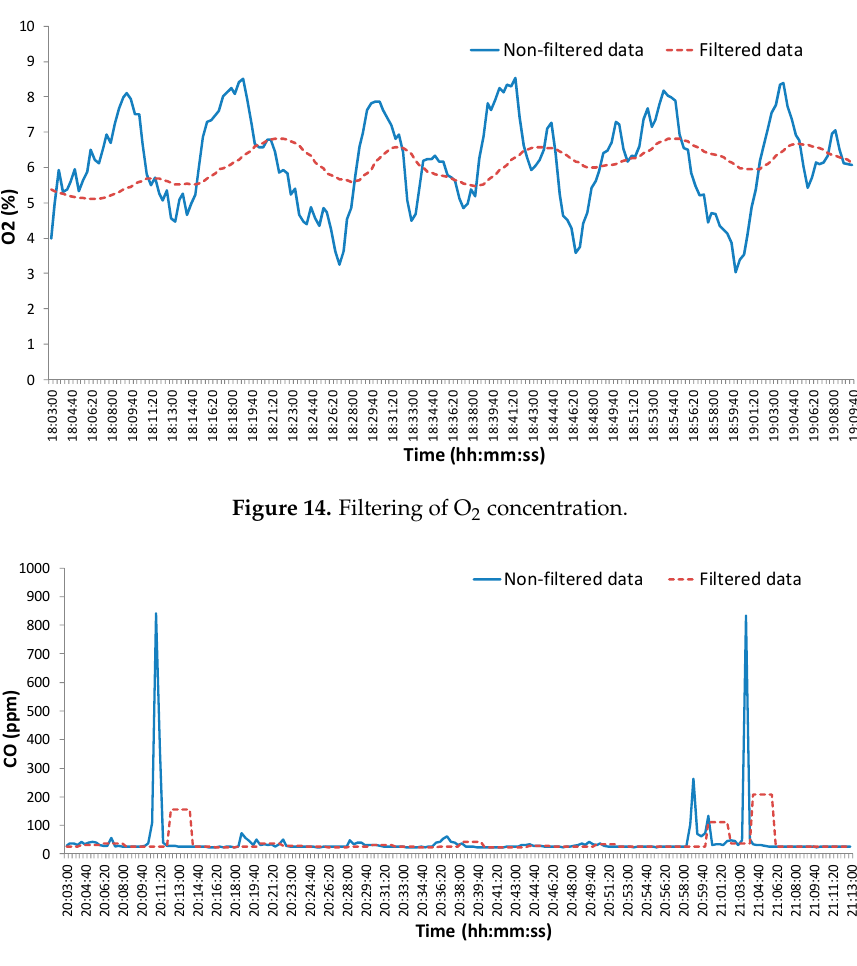
Figure 15. Filtering of CO concentration.